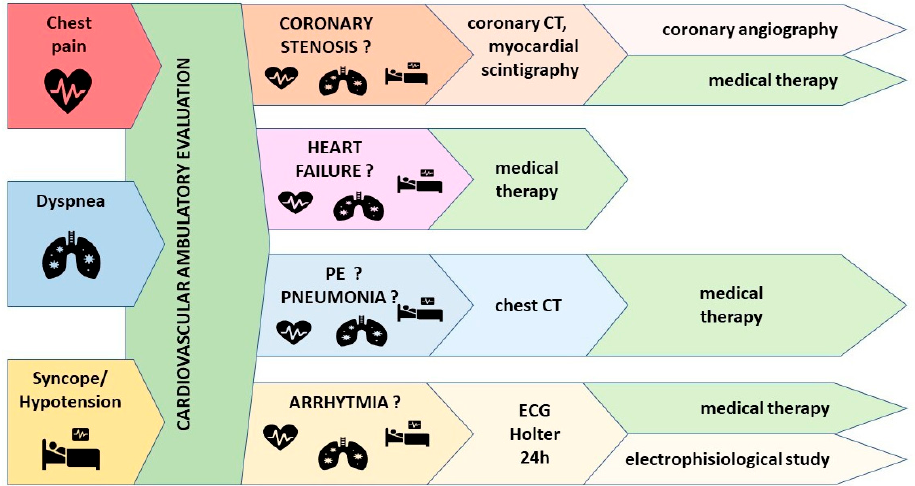
Figure 2. Management protocol of cardiovascular adverse events during CFZ therapy. CT: computed tomography, PE: pulmonary embolism.